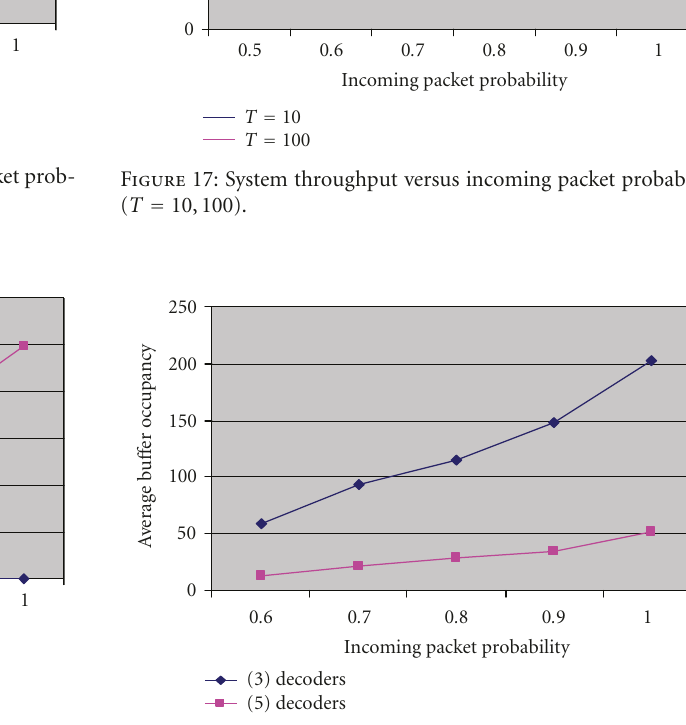
Figure 18: Average bu ff er occupancy versus incoming packet prob- ability for di ff erent number of sequential